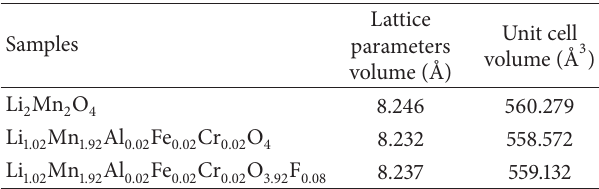
Table 1: Lattice parameters of